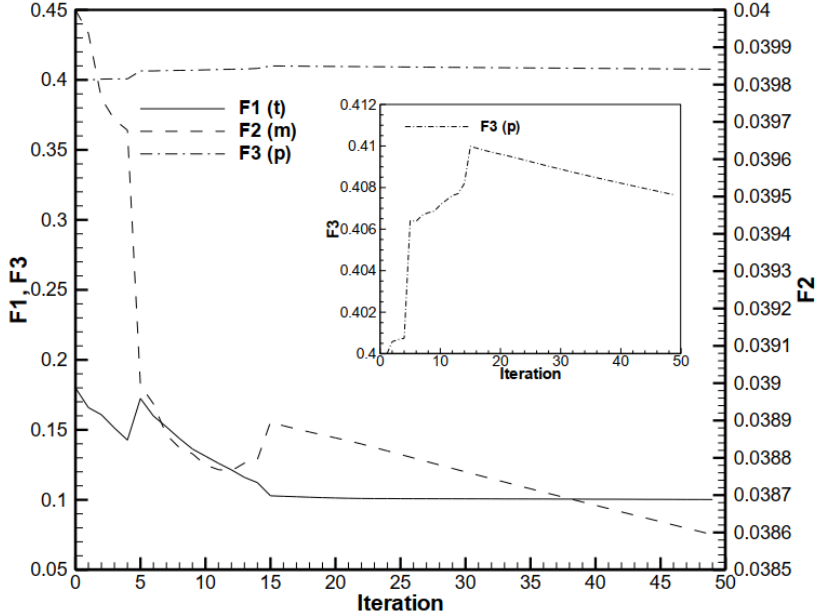
Figure 6. The variations in the airfoil design parameters when applying the multipurpose lift-to-ratio optimization algorithm are shown, including the maximum thickness t , the location of the bend m , and the maximum bend p